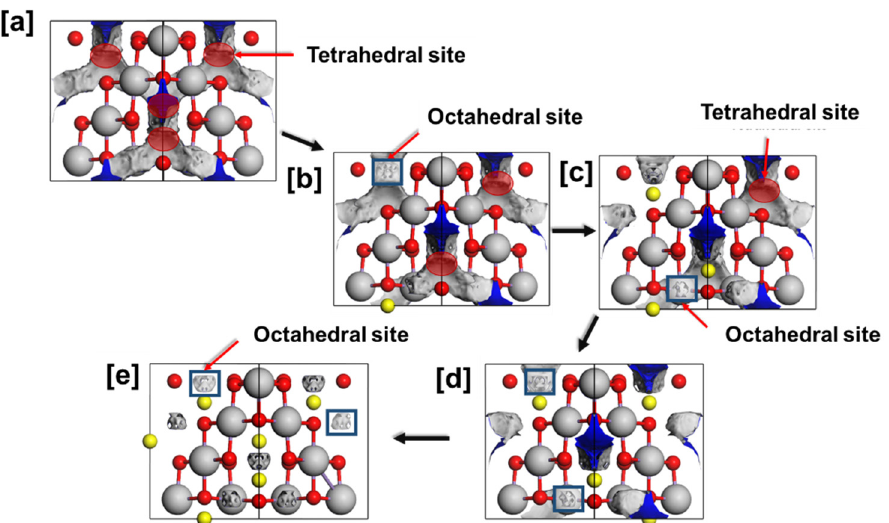
Figure 5. The variation in the electrostatic potential at different lithium concentrations in the spinel Li x Mn 2 O 4 (0 ≤ x ≤ 1) structure. ( a ) λ -Mn 2 O 4 , ( b ) Li 0.25 Mn 2 O 4 , ( c ) Li 0.5 Mn 2 O 4 , ( d ) L i0.75 Mn 2 O 4 and ( e ) Li 1.0 Mn 2 O 4 .